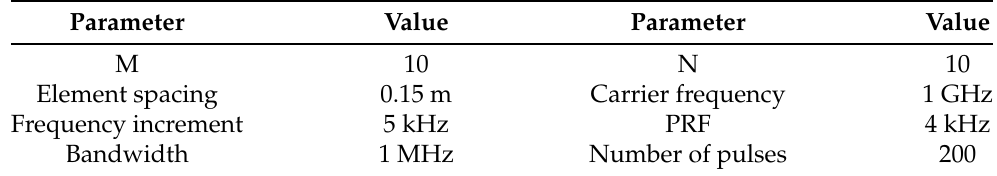
Table 1. FDA-MIMO radar parameters.